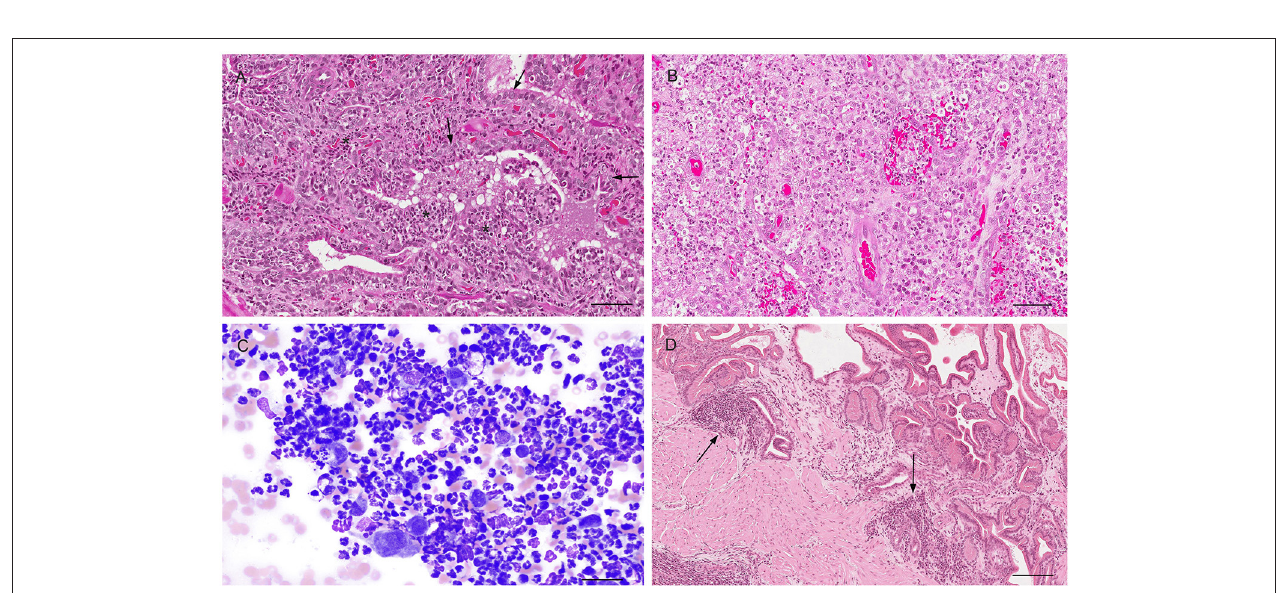
FIGURE 6 | Histological subtypes of prostatic hyperplasia in dogs: (A) Glandular hyperplasia: large alveoli with numerous intraluminal papillary projections admixed with a reduced amount of stroma. Hematoxylin-eosin staining. Bar = 100 µ m. (B) Complex hyperplasia: multifocal lesion with dilated and cystic alveoli. Note the randomly scattered aggregates of inflammatory cells (arrows). Hematoxylin-eosin staining. Bar = 200 µ m.